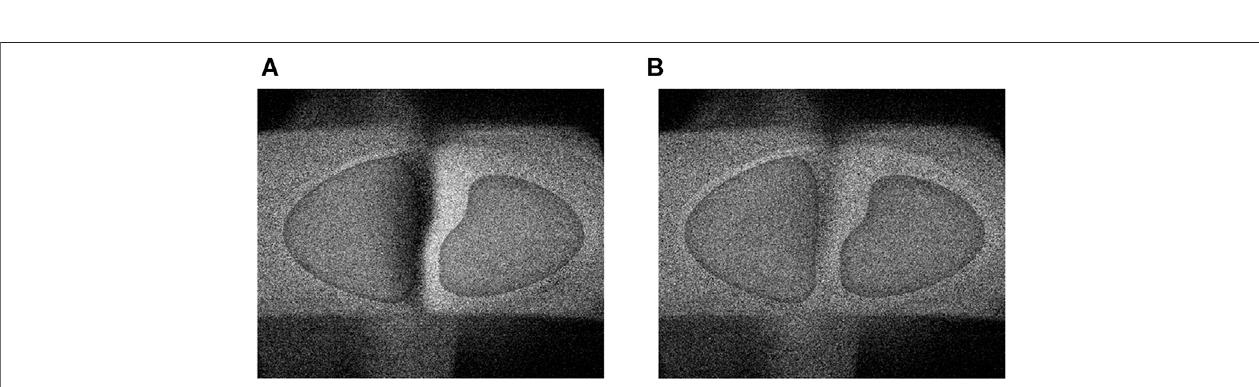
FIGURE 8 | Differential images of (A) 2.0 – 0 vol.%, and (B) 0.2 – 0 vol.% as gray-scale images. The luminance differences were magni fi ed 100-times for